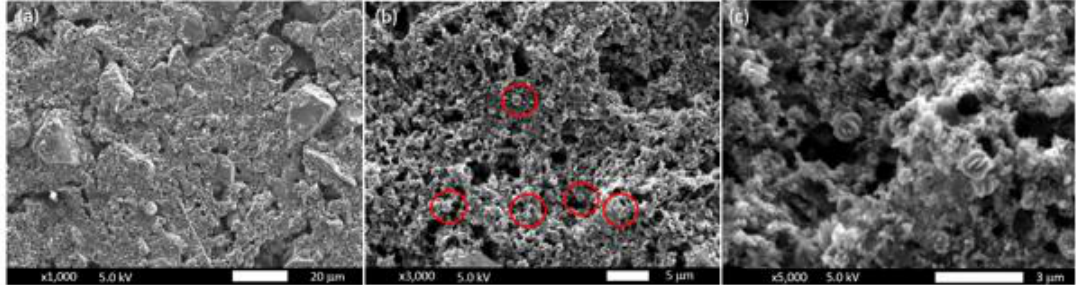
Figure 6. SEM images of ( a ) the pre-cycling electrode and ( b , c ) the post-cycling electrode.